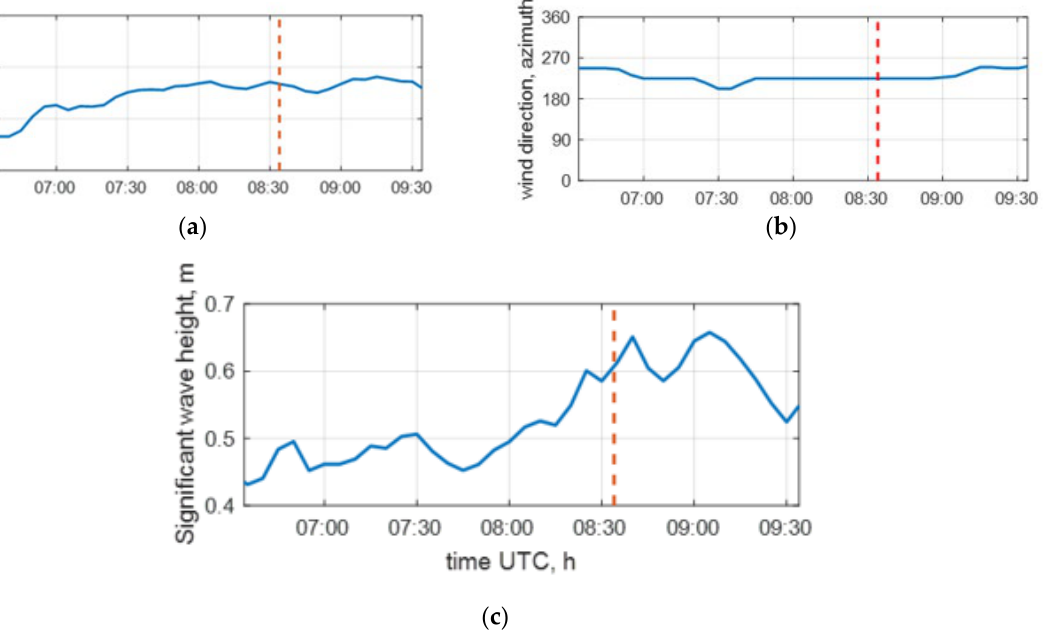
Figure 7. Meteorological conditions of the sea truth experiment: wind speed at the horizon of 10 m ( a ), wind direction ( b ); significant wave height ( c ). The vertical line marks the time of the satellite survey.